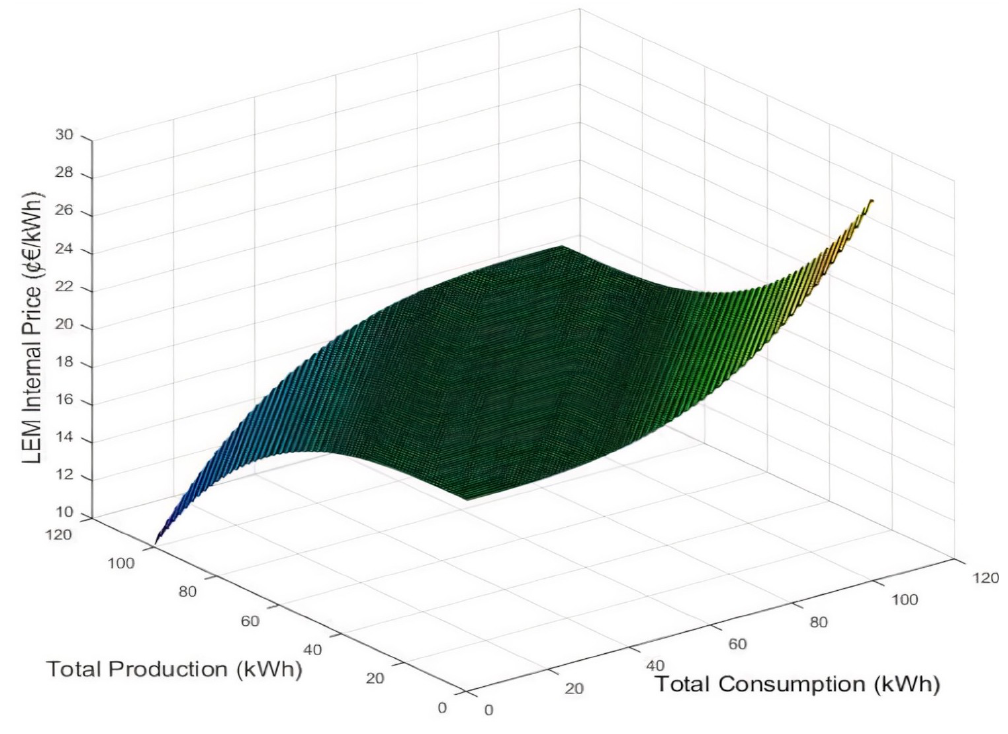
Figure 6. LEM pricing curves with feed-out and feed-in tariffs as